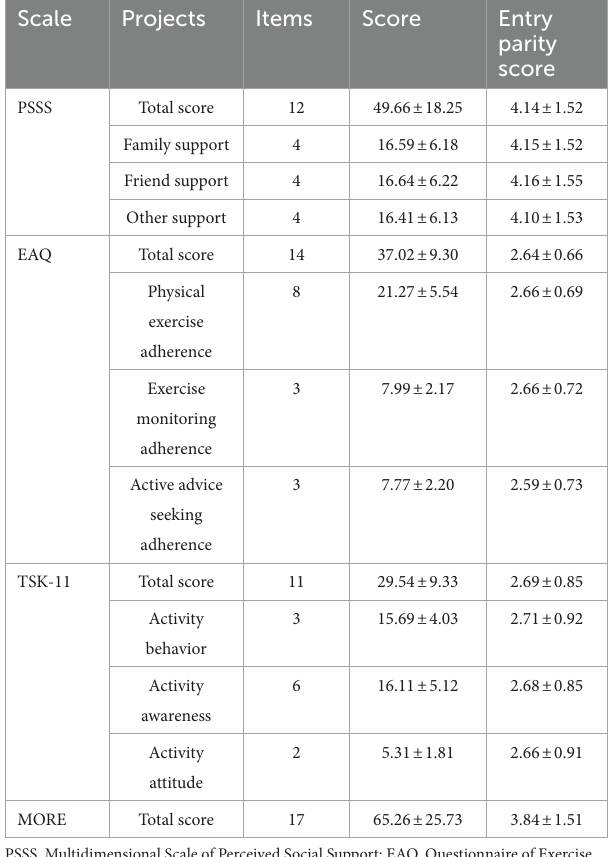
TABLE 2 Scores on the PSSS, EAQ, TSK-11, and MORE ( n = 350 ， x ±s ). Scale